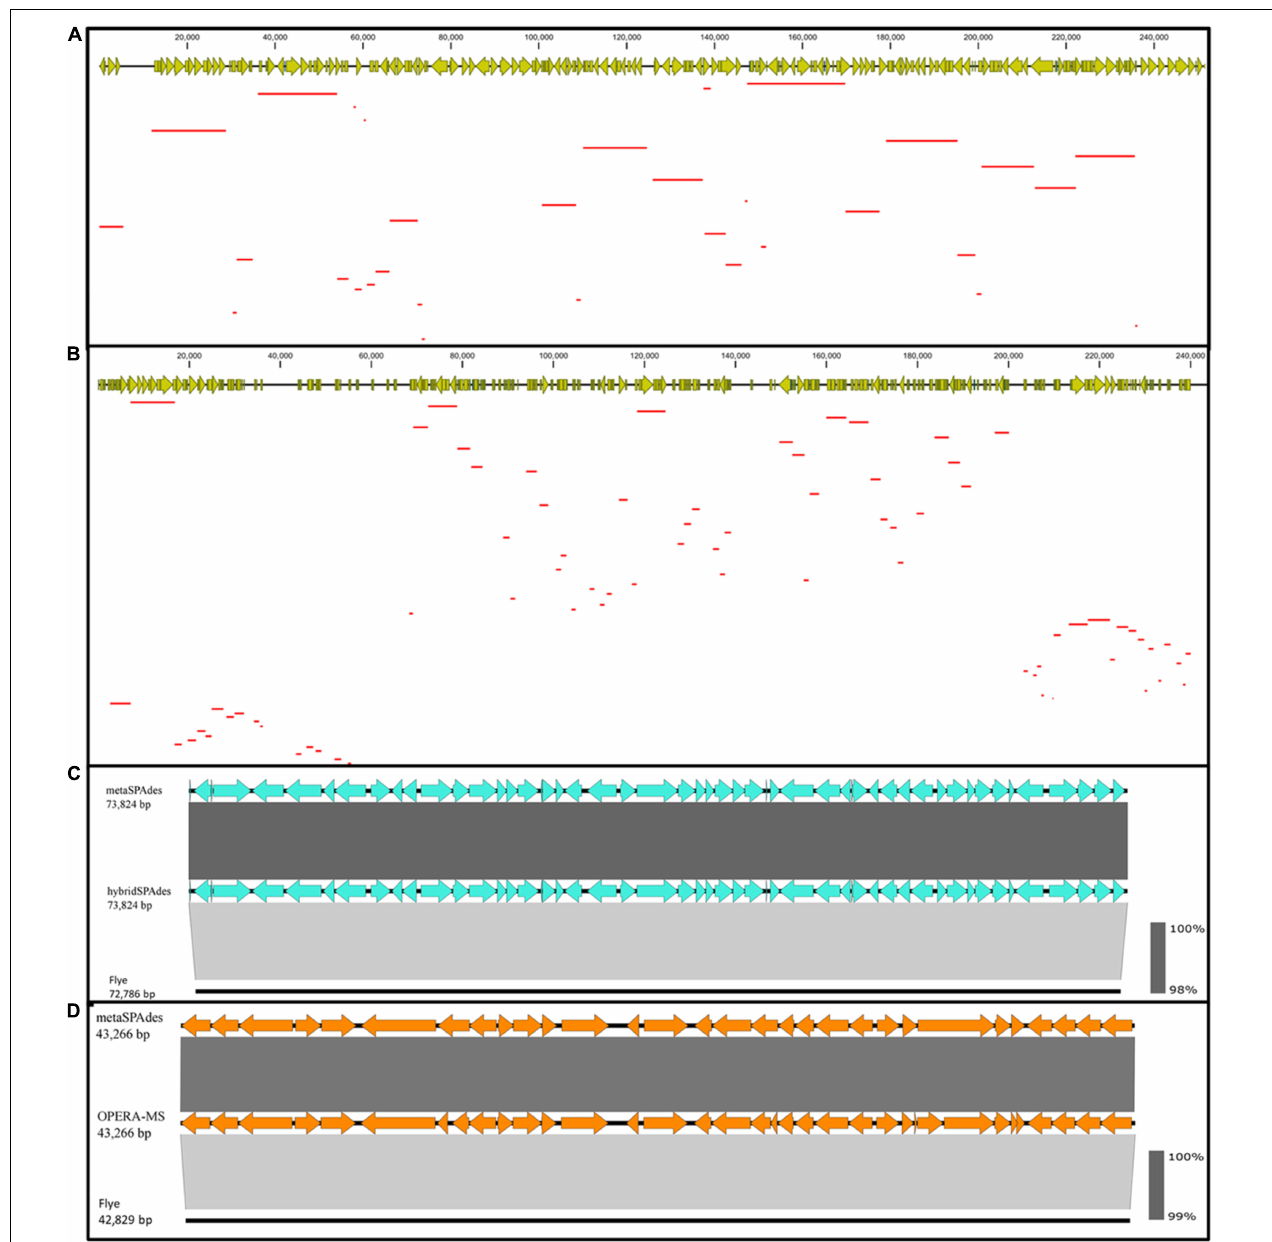
FIGURE 4 | Contiguity and accuracy of assembly with four different assembly algorithms. BLASTN of a 242,790 bp (A) and 242,845 bp (B) contigs assembled using hybrid assembly methods, hybridSPAdes (A) , and OPERA-MS (B) against the metaSPAdes assembly with Illumina reads alone. This result indicated that the hybrid assembly generates more contiguous contigs. Linear alignment of contigs assembled using hybridSPAdes [ (C) ∼ 73,824 bp] and OPERA-MS [ (D) ∼ 43,266 bp] with assemblies constructed using Flye and metaSPAdes. The results indicated that the hybrid assembly generated contigs with high accuracy. The red lines represent Illumina contigs matched to hybrid assembled